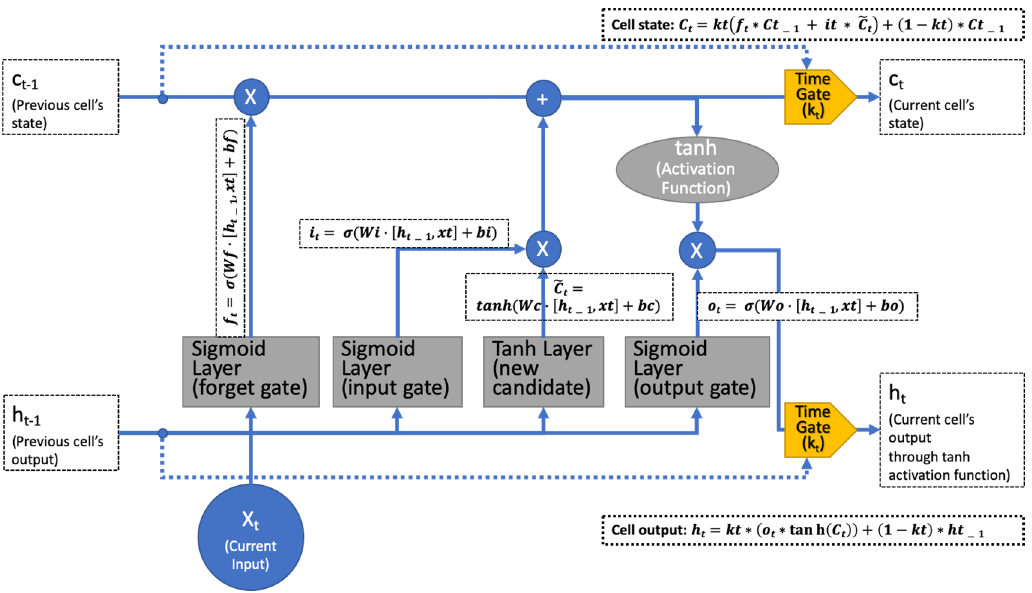
Figure 3. Phased LSTM using rectified linear units as the time-gate kt that propagates the gradient